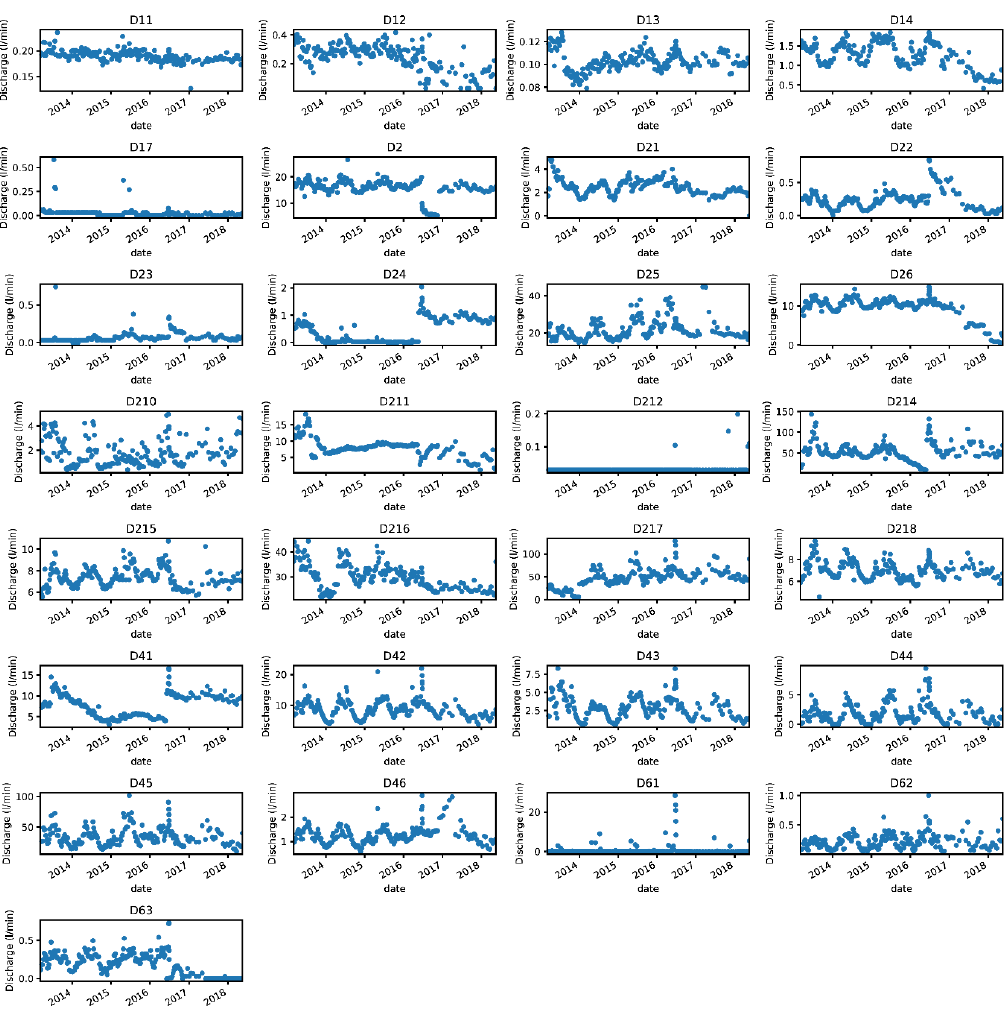
Figure A8. Time series plot of 29 monitored drains.